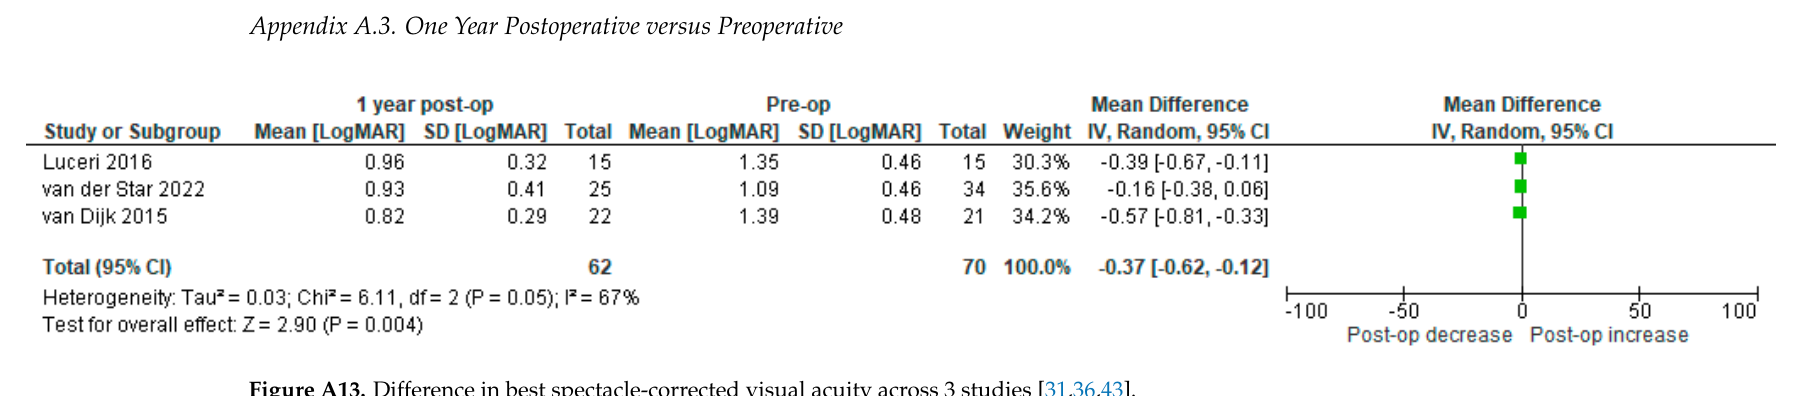
Figure A15. Di ff erence in pachymetry thinnest point across 3 studies [32,37,43].